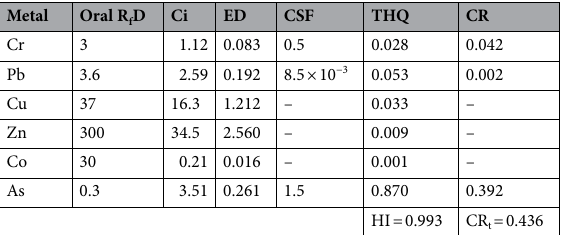
Table 8. Carcinogenic and non-carcinogenic health risk assessment from seaweed consumption in adults in Bangladesh. Oral R f D and CSF values were obtained from Kamuda et al. 80 , and Kortei et al. 42 , and Shams et al. 43 respectively.